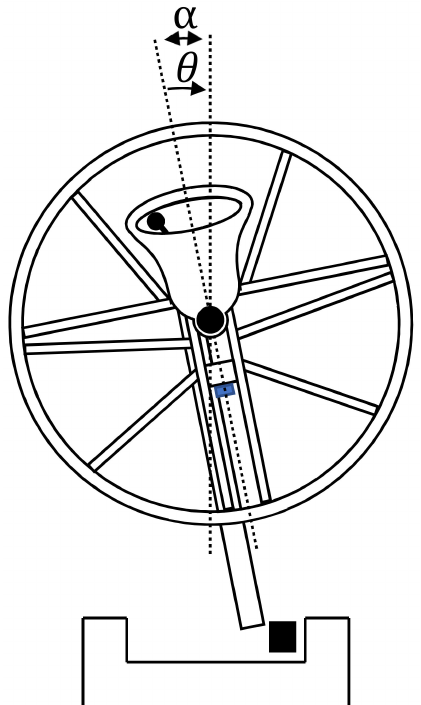
Figure 2. Diagram of a bell and bell wheel. The blue box indicates where the sensor was located in all experiments in the Cathedral. The black slider holds the bell in position close to its balance point so that minimum effort is required to ring